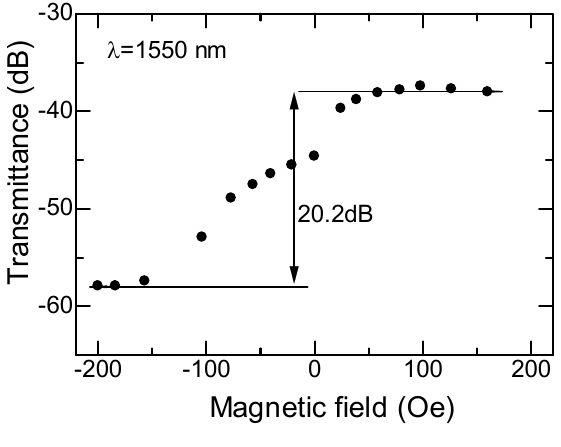
Figure 12. Measured fiber-to-fiber transmittance of semileaky waveguide optical isolator as a function of applied magnetic field at a wavelength of 1,550 nm [12]. A coupling loss of 15 dB/facet between the butt-coupled PMF and the waveguide is included in the